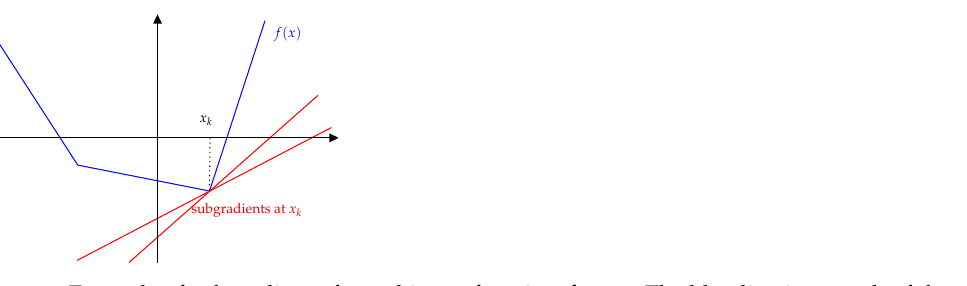
Figure 1. Example of subgradient of an arbitrary function f at x k . The blue line is a graph of the function f and the red lines are possible candidates of subgradient.